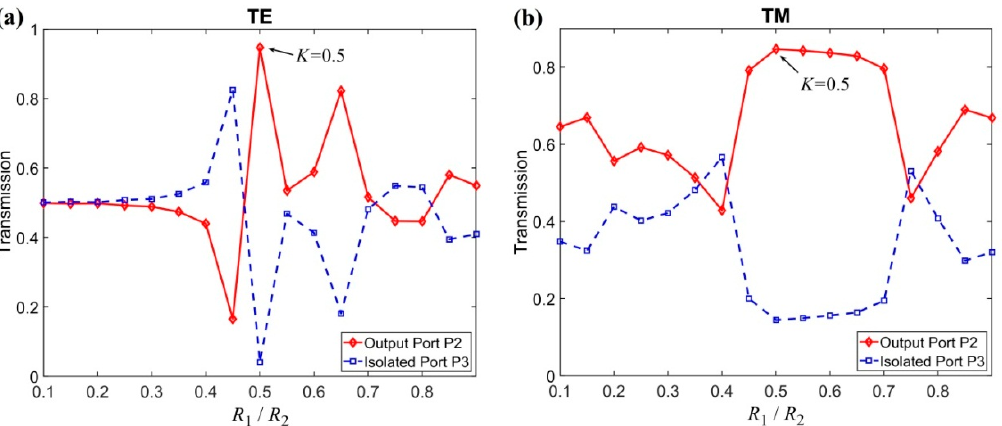
Figure 4. Transmissions of the output port P2 and isolated port P3 versus the radius ratio K = R 1 / R 2 for ( a ) TE and ( b ) TM polarization.